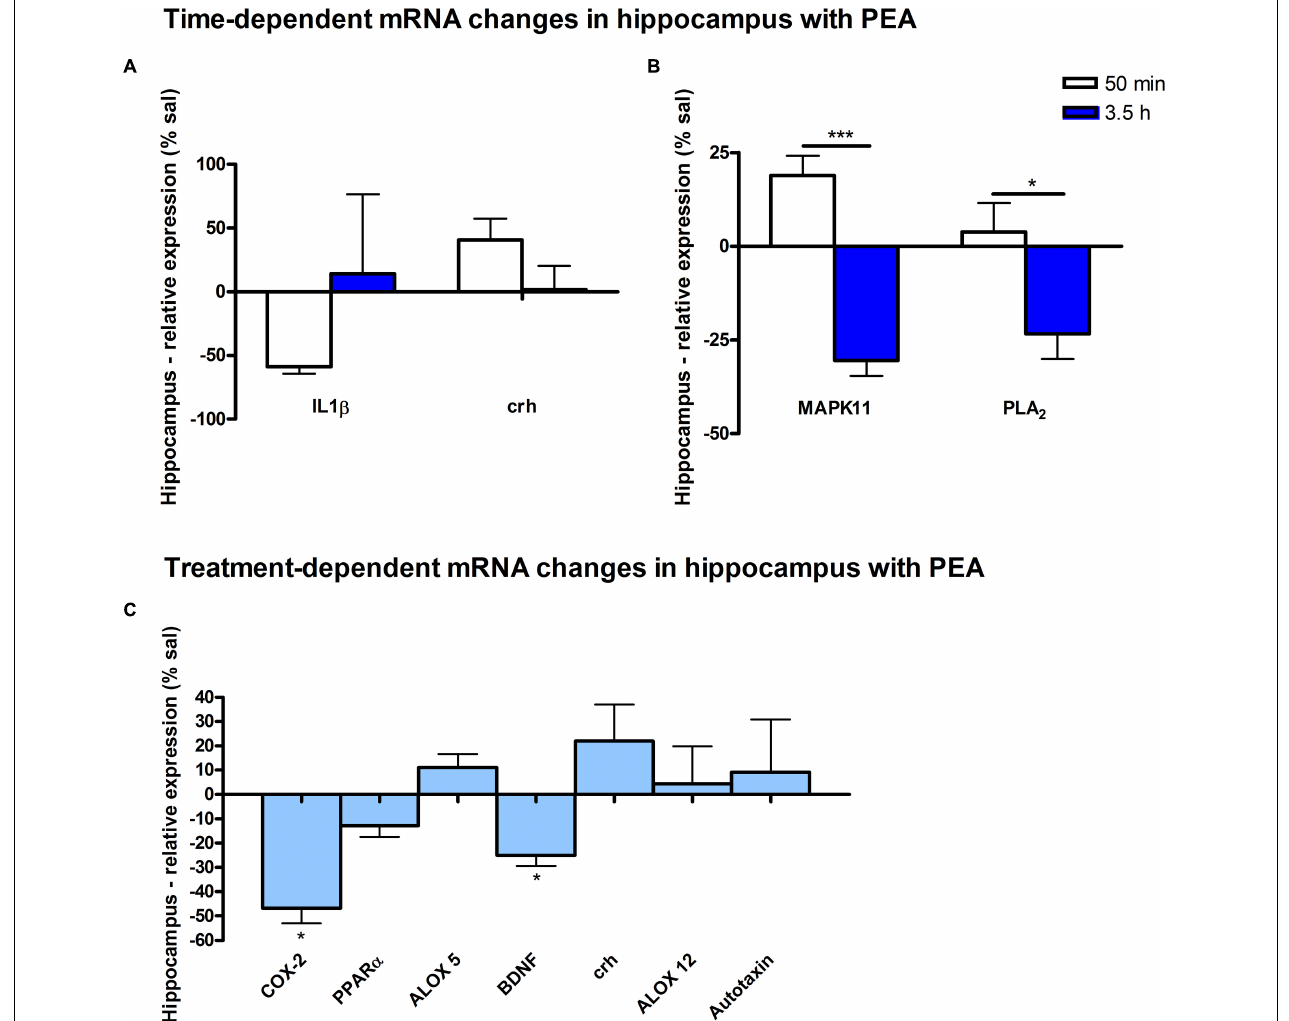
FIGURE 8 | mRNA levels of hippocampus after PEA treatment: relative mRNA values after PEA treatment as percentage of saline treated mice, presented as mean value ± SEM. (A) Time point 1: time specific mRNA changes after 50 min of sub-chronic PEA treatment. Relative mRNA levels for two different time points are shown and only genes significantly changing after 50 min of PEA treatment are depicted. (B) Time point 2: time-specific mRNA changes after 3.5 h of PEA treatment. Relative mRNA levels for two different time points are shown and only genes significantly changing after 3.5 h of PEA treatment are depicted. Significant differences between the time points underline time specificity for these mRNAs and are depicted on the graph when occurring. (C) Merged time points: relative mRNA levels for merged time points. Changes for COX-2 and Bdnf are significant when pooling the time points. Data were considered significant at a p -value < 0.05, e.g., ∗∗∗ p < 0.001, ∗∗ p = 0.001 to 0.01; ∗ p = 0.01 to